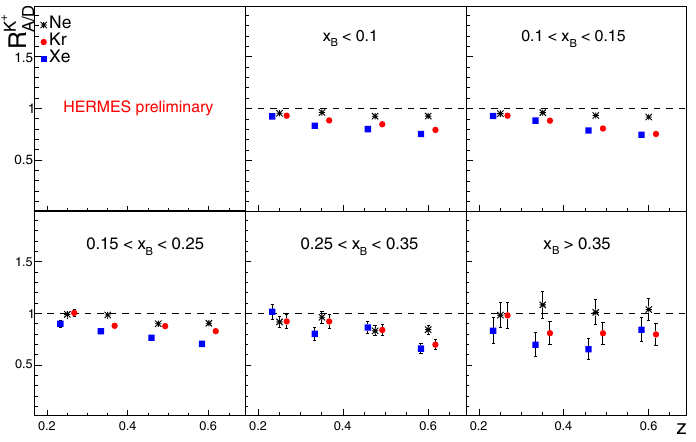
Figure 2. R K + ( z ) dependences for positively charged kaons at five x B slices, the error bars are squared A / D sum of statistical and systematical uncertainties